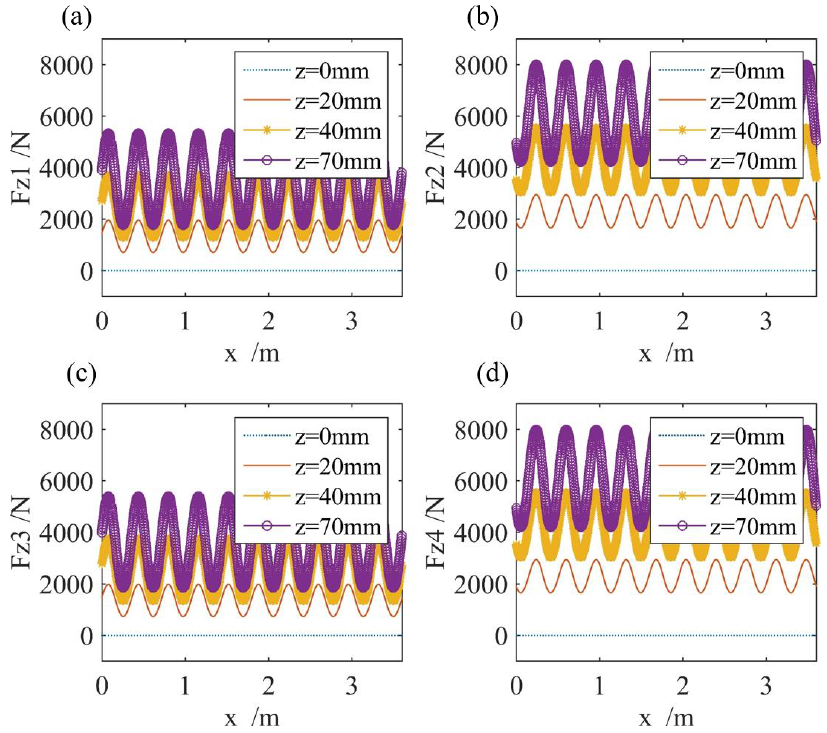
Figure 5. Levitation force on left SCMs when 13 mps v = and 300 kAt MMF = : ( a ) levitation F 1 z ( x ) ; ( b ) levitation force F 2 z ( x ) ; ( c ) levitation force F 3 z ( x ) ; ( d ) levitation force F 4 z ( x )